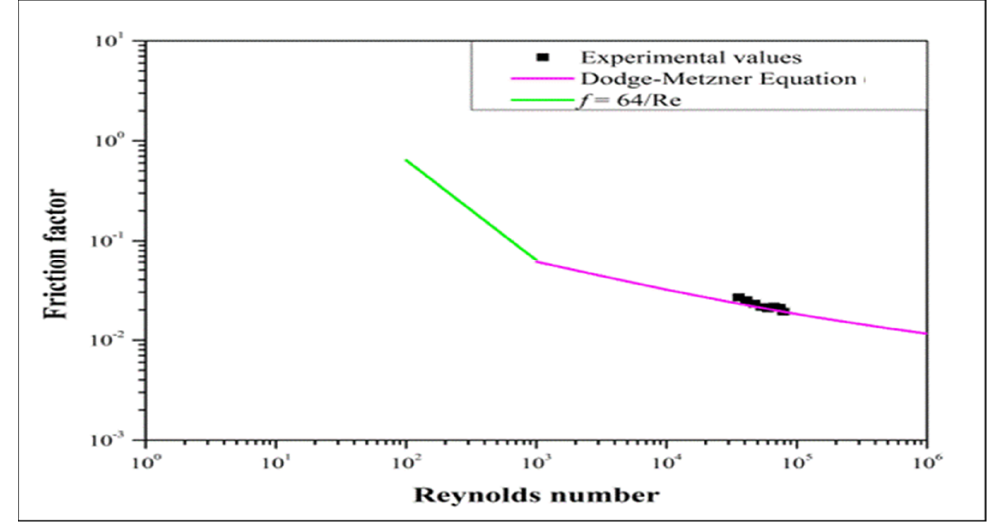
Figure 4. Comparison of the experimental friction factor values estimated from water-only flow tests against the ones calculated from the Dodge and Metzner equation [24].